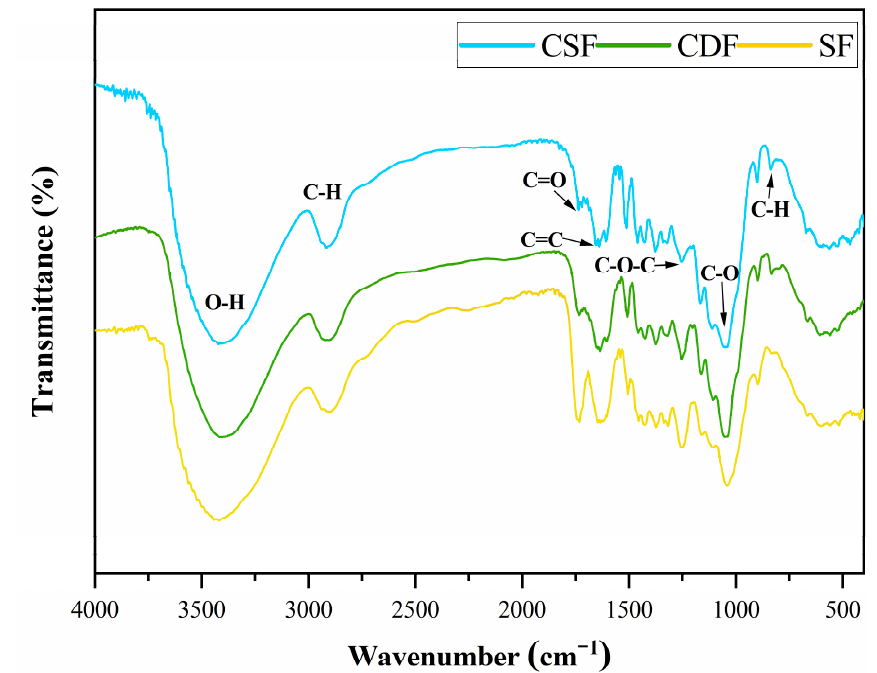
Figure 4. FTIR spectra of the fiber samples CDF, CSF, and SF.